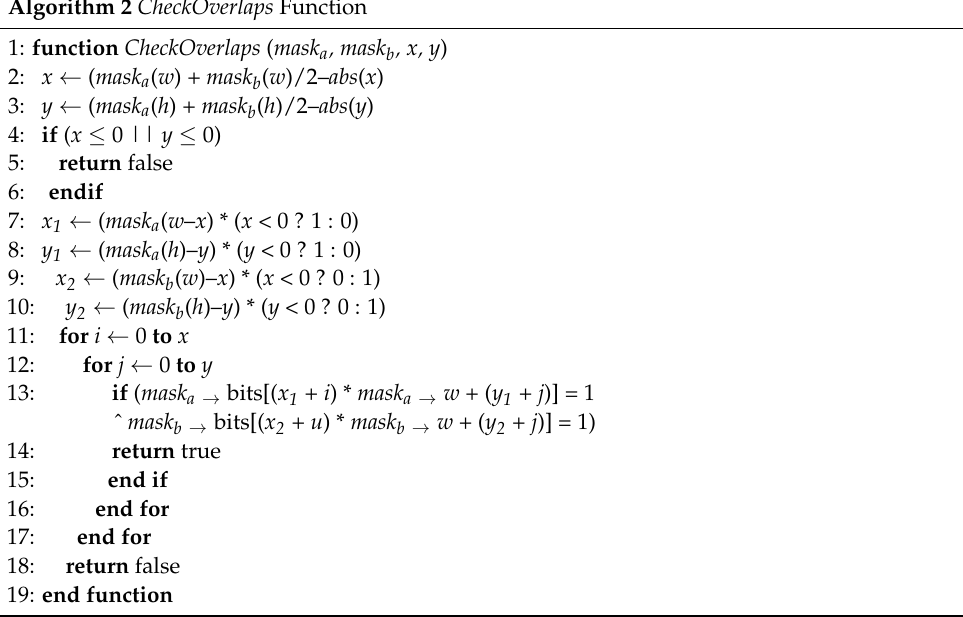
Algorithm 2 CheckOverlaps